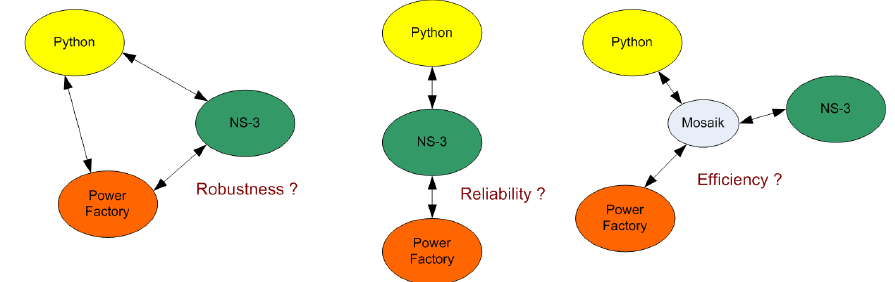
Figure 6. Illustration of technical layer of a CPES co-simulation